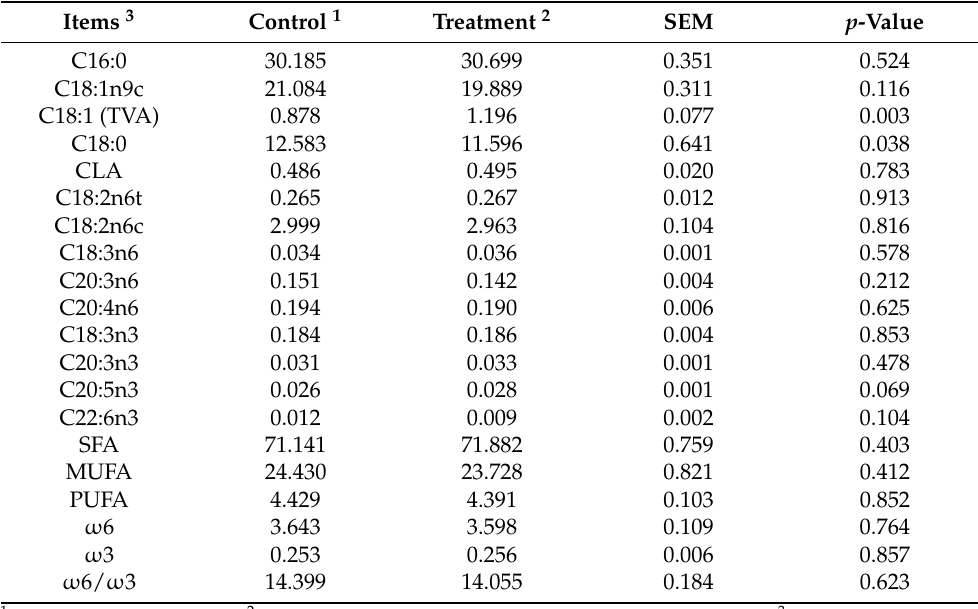
Table 10. Effects of noni meal on milk fatty acids composition (%) in Holstein dairy